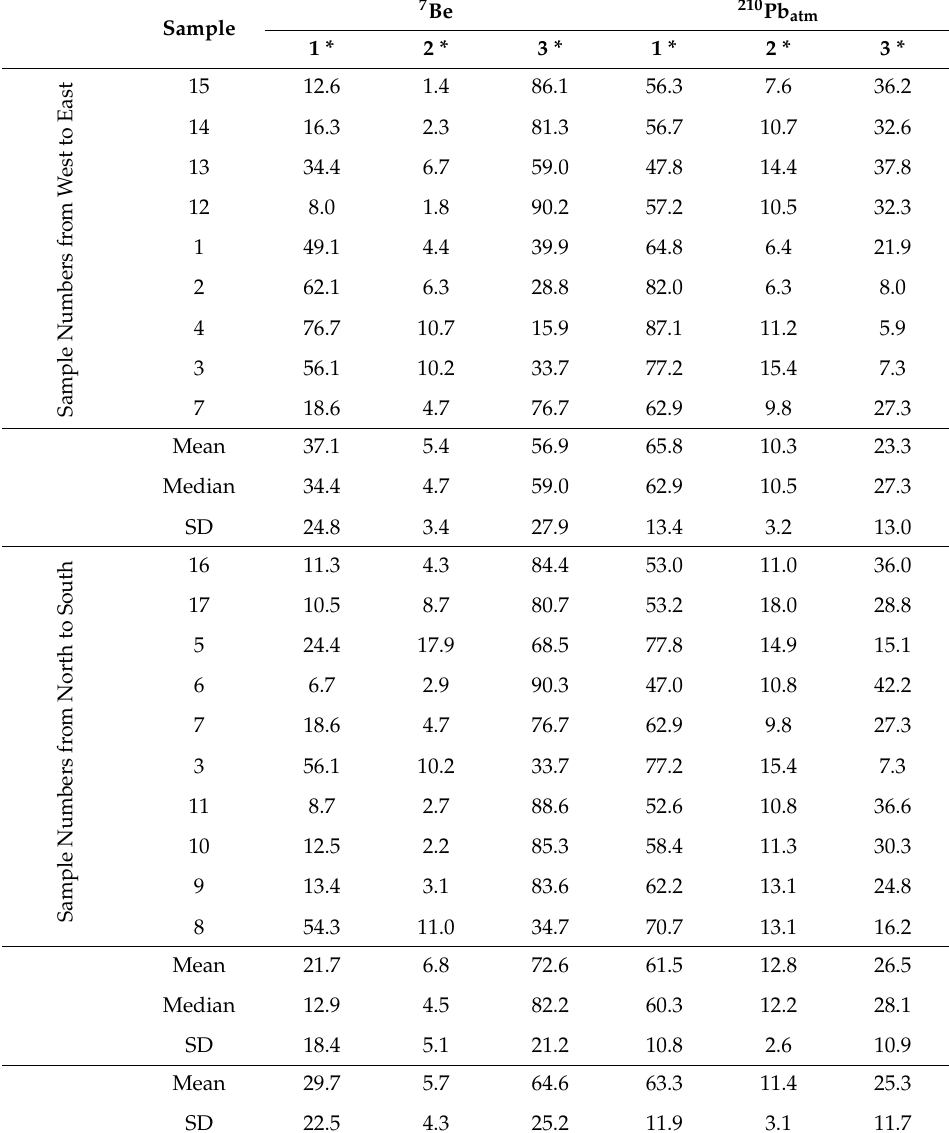
Table 3. The contribution of particulate fractions (%) of suspended matter in snow water to 7 Be and 210 Pb atm total activity.